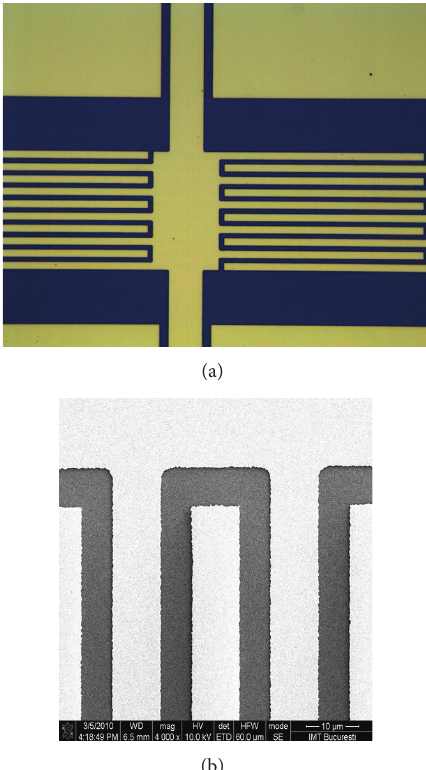
Figure 3: Configuration of the active part of the CRLH antenna— interdigital capacitors and part of the inductor lines—(a) and a SEM image showing a detail of an interdigital capacitor